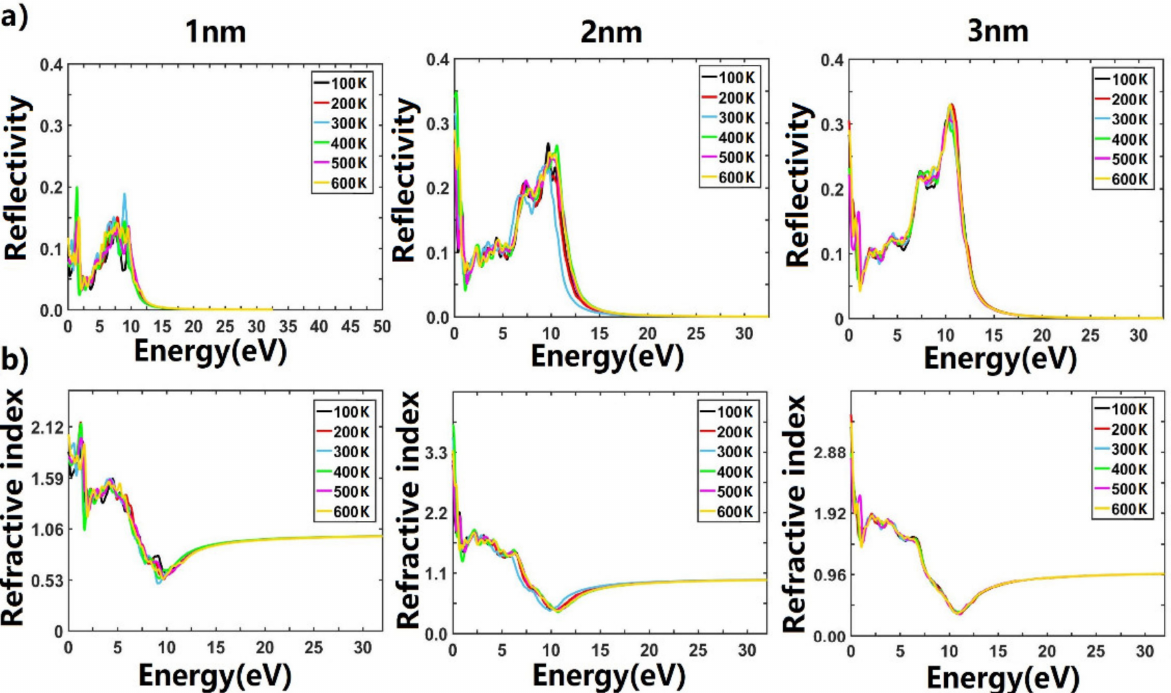
Figure 7. ( a ) Reflectivity spectra and ( b ) refractive index of 1, 2, and 3 nm ITO models at temperatures ranging from 100 to 600